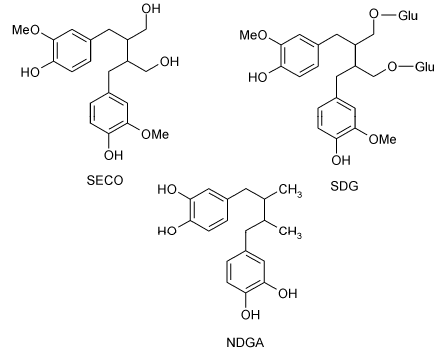
Figure 1. Chemical structure of secoisolariciresinol diglucoside (SDG), secoisolariciresinol (SECO), and nordihydroguaiaretic acid (NDGA).